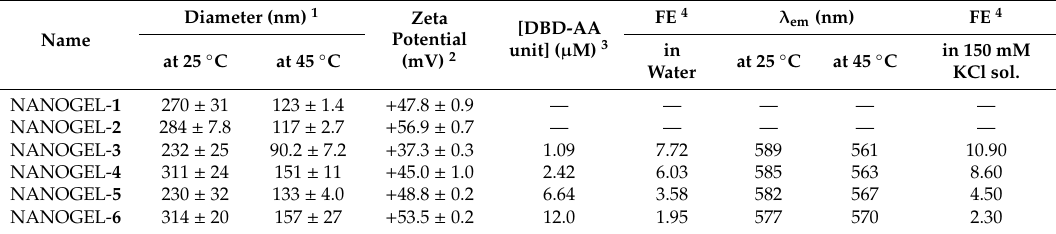
Table 2. Physical and photophysical properties of cationic nanogels (NANOGEL- 1 and NANOGEL- 2 ) and cationic fluorescent nanogel thermometers (NANOGEL- 3 ~ 6